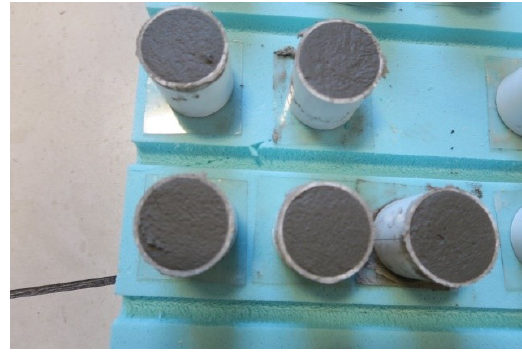
Figure 2: Samples of deformable cement adhesive mortars